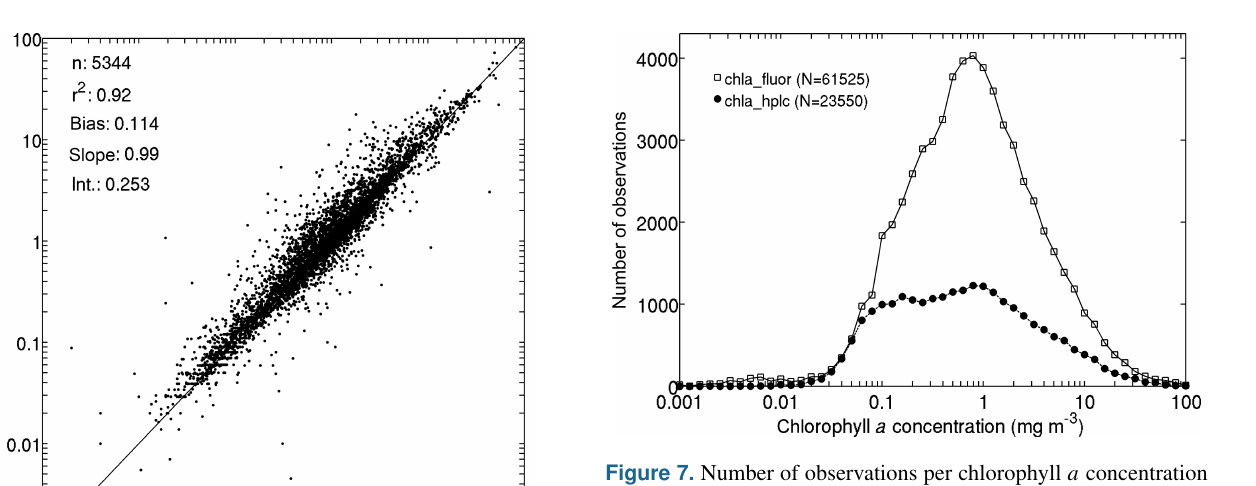
Figure 7. Number of observations per chlorophyll a concentration acquired with different methods (chla_fluor and